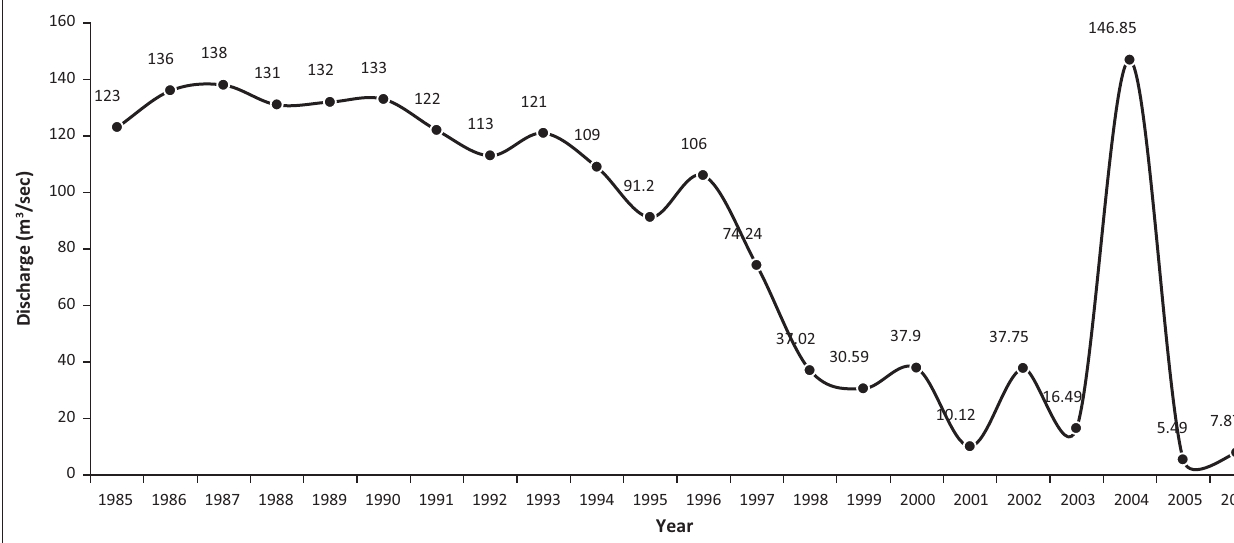
FIGURE 4: Yearly recorded minimum discharge at Kaunia station from 1985 to